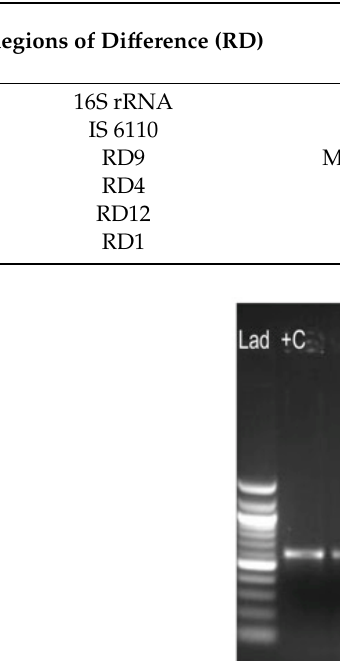
Table 2. PCR results for 136 Pyranizamide (PZA )resistant Mycobacterium tuberculosis complex.